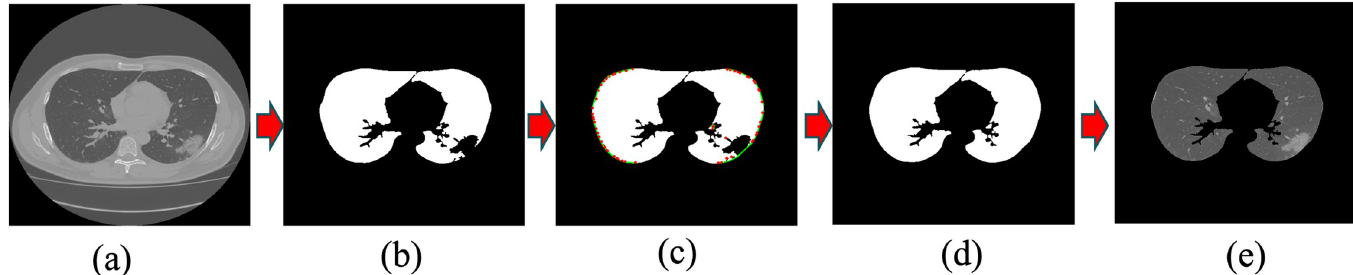
Fig 1. Shows the workflow of lung segmentation: In (a) we show an original image of lung CT scan, and (b) shows a binary mask of the original image. Since the pixel intensities of GGO and bone regions are similar to each other, the binary mask shows an incomplete structure of the lung. Some parts of the lungs are missing. To restore the missing parts, we applied the convex hull algorithm to the binary mask. The convex hull algorithm detects convex points [red dots in Fig 1C], and we compute pairwise Euclidean distances to connect nearest-neighbor points by a green line if the distance between them is less than 80 pixels [Fig 1C]. Fig 1D and 1E show the restored mask and the corresponding RGB image,